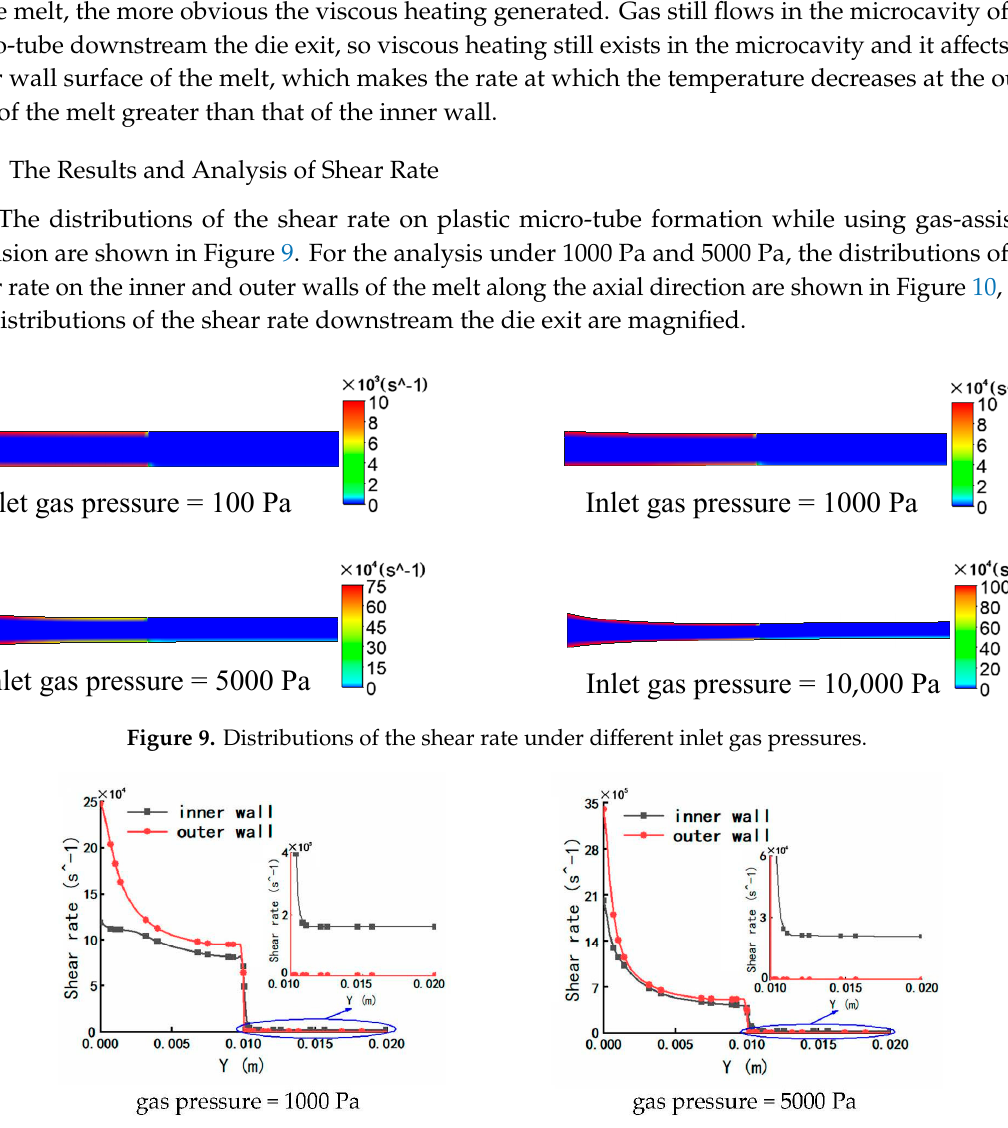
Figure 10. Distributions of shear rate on the inner and outer wall of the melt.